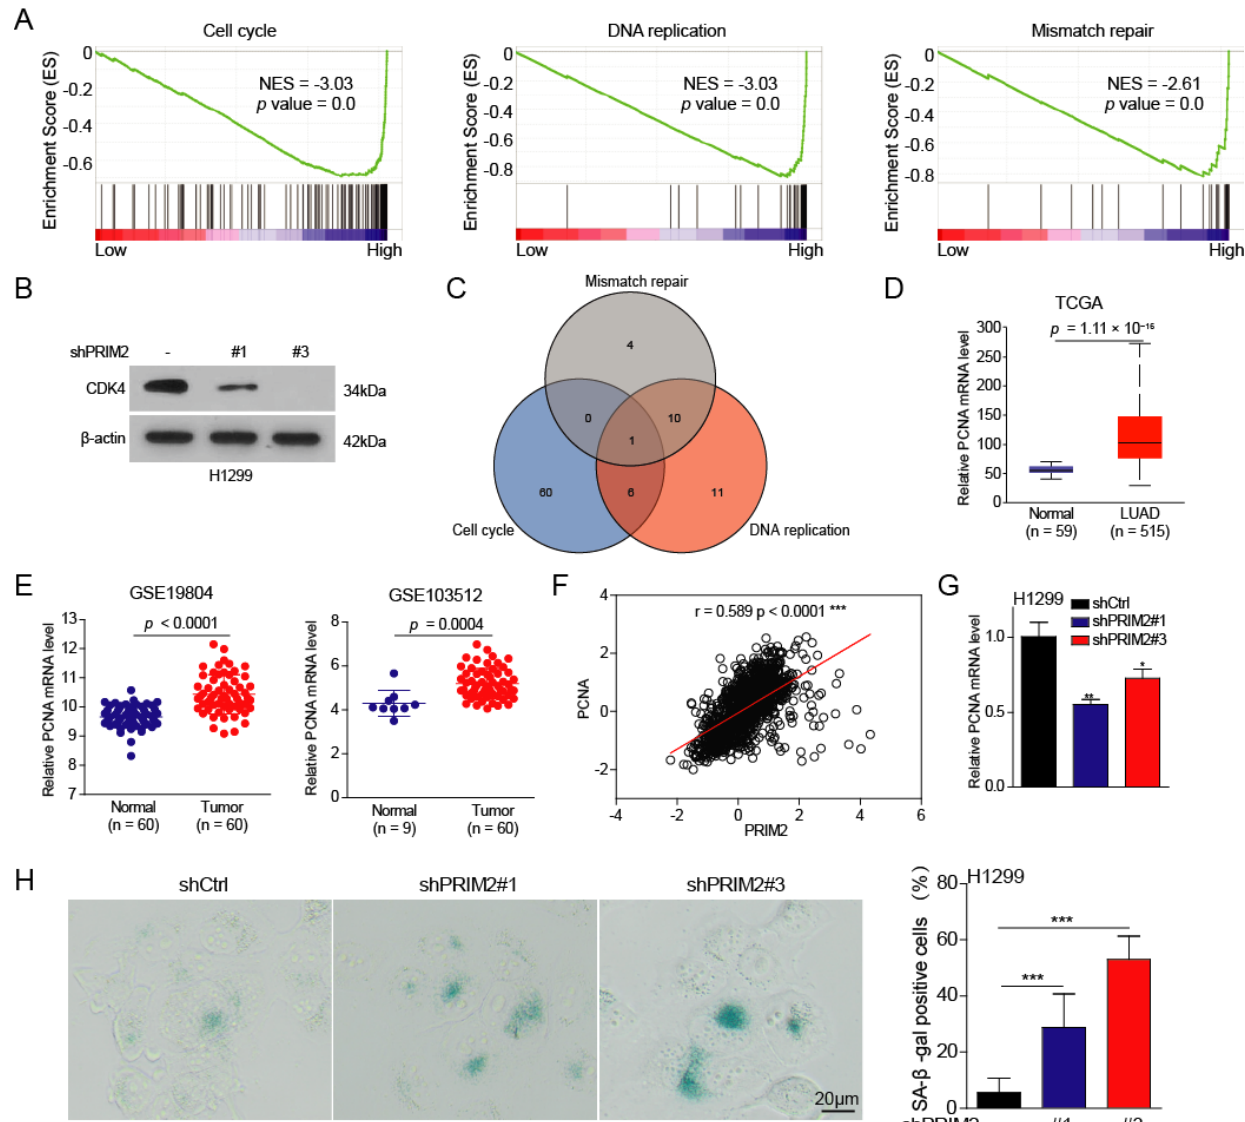
Figure 2. PRIM2 activates the cell cycle and promotes DNA repair in lung cancer. ( A ) GSEA analysis of the PRIM2 signature in patients with lung cancer. ( B ) The expression of CDK4 in H1299 cells with PRIM2 knockdown. ( C ) The overlapping analysis for target genes of the cell cycle, DNA replication, and mismatch repair in lung cancer patients. ( D , E ) The PCNA mRNA expression levels were analyzed for tumor and normal tissues. ( F ) The expression correlation between PRIM2 and PCNA. ( G ) The PCNA mRNA expression levels were examined in H1299 cells with PRIM2 knockdown. ( H ) Cell senescence assay was performed on H1299 cells with PRIM2 knockdown. * p < 0.05; ** p < 0.01; *** p < 0.001. The uncropped WB figures are in Figure S1.